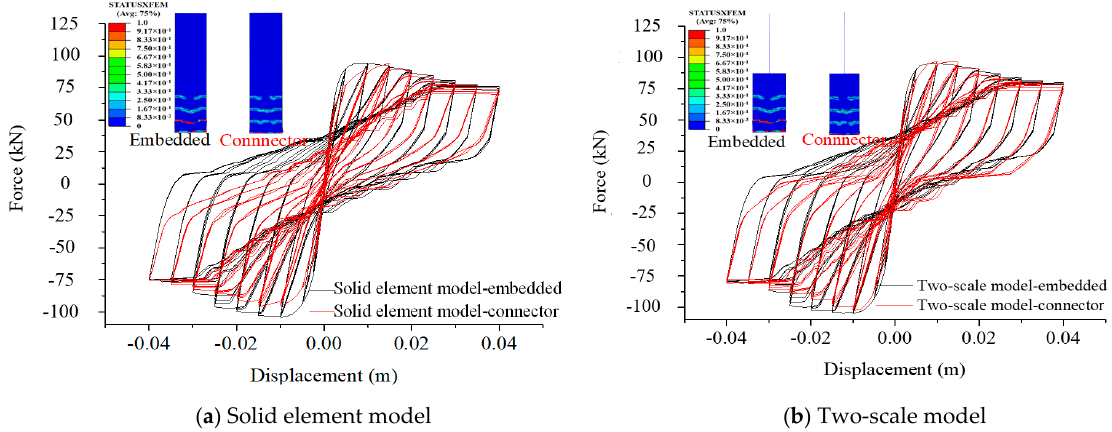
Figure 9. Comparison of load ‐ displacement curves with and without considering bond ‐ slip effect.